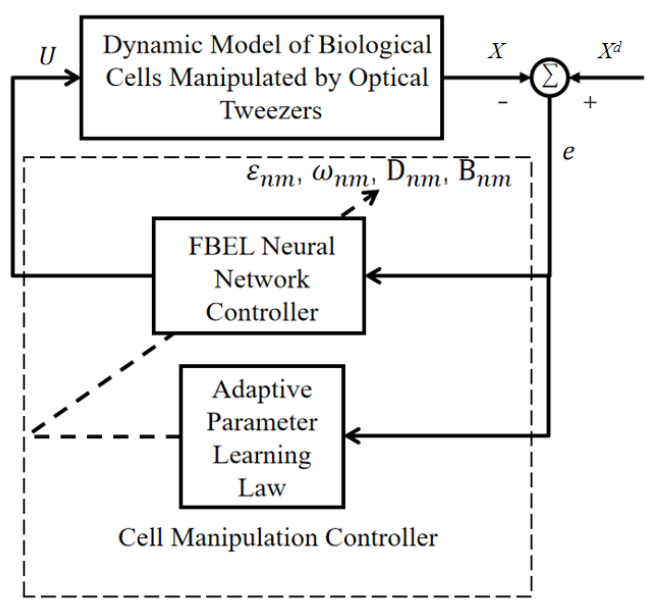
Figure 4. Structure diagram of a closed-loop system based on the FBEL neural network.